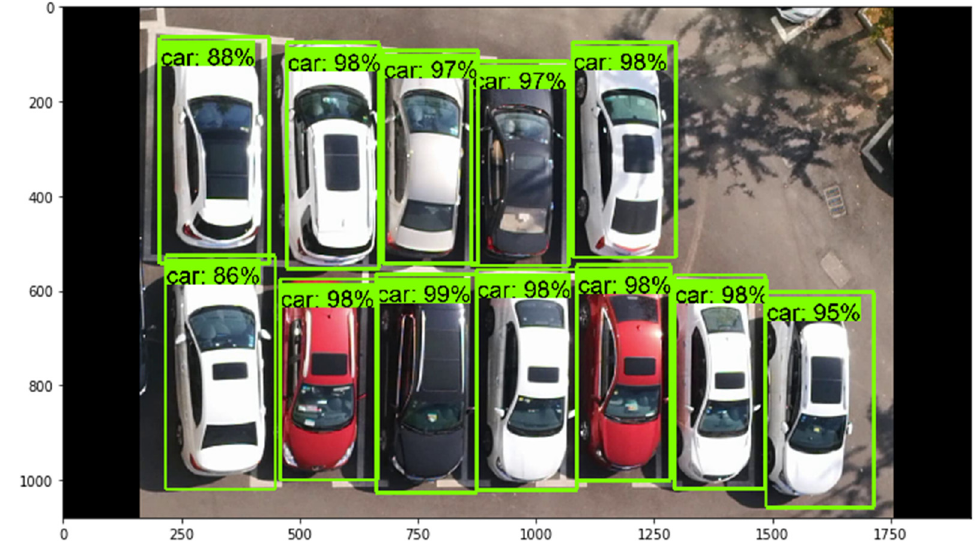
Figure 14. Identification effect of vehicles using the training model.